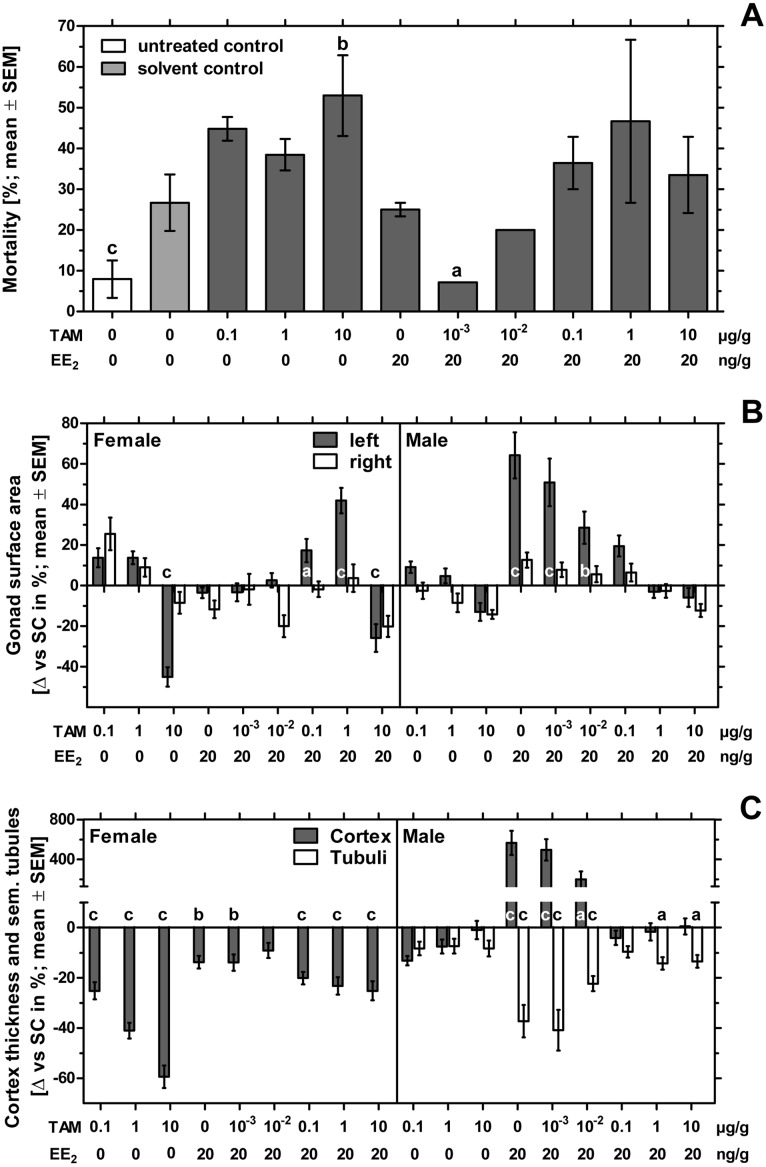
Effects of in ovo exposure to tamoxifen and 17α-ethinylestradiol on mortality, left and right gonad surface area, cortex thickness and percentage of seminiferous tubules of left gonad of embryos of the domestic fowl (Gallus g. domesticus).Effects of in ovo exposure to tamoxifen (TAM, 0.001, 0.01, 0.1, 1, 10 µg/g egg) and 17α-ethinylestradiol (EE2, 20 ng/g egg) on mortality (A), left and right gonad surface area (B) and cortex thickness and percentage of seminiferous tubules of left gonad (C) of embryos of the domestic fowl (Gallus g. domesticus) on embryonic day 19. Statistical analysis by Fisher’s exact test (A), one-way ANOVA with Dunnett’s multiple comparisons test or Kruskal-Wallis test with Dunn’s multiple comparison test (B, C). Grey background distinguishes the co-exposure to tamoxifen and EE2. Lowercase indicates significant differences compared to the solvent control. Level of significance: a, p < 0.05; b, p < 0.01; c, p < 0.001.